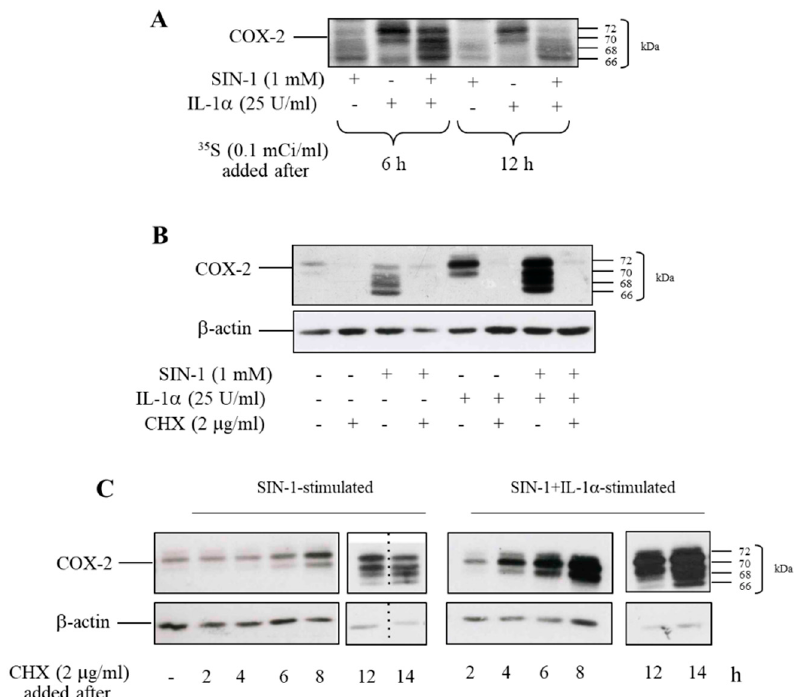
Figure 4. SIN-1 induces a de novo synthesis of hypoglycosylated COX-2. HUVEC were treated with SIN-1 or IL-1 α , either alone or in combination for 18 h. ( A ) Tran [ 35 S]-label was added 6 or 12 h after the beginning of incubation. At the end of incubation, COX-2 was immunoprecipitated. ( B ) Cells were treated with the stimuli for 18 h in the presence of cycloheximide (CHX). ( C ) CHX was added to HUVEC incubated with SIN-1 or SIN-1 + IL-1 α , either alone or in combination, at different time after the start of incubation, as indicated. COX-2 expression was evaluated by Western blot analysis. β -actin was used as a control of protein loading. Samples with CHX added for 12 and 14 h-treatment were run on separate parallel gels. For SIN-1-treated cells, the samples for the cells treated with CHX added for 12 and 14-h were run on the same gel but were non-contiguous. Results are representative of 3 independent experiments.